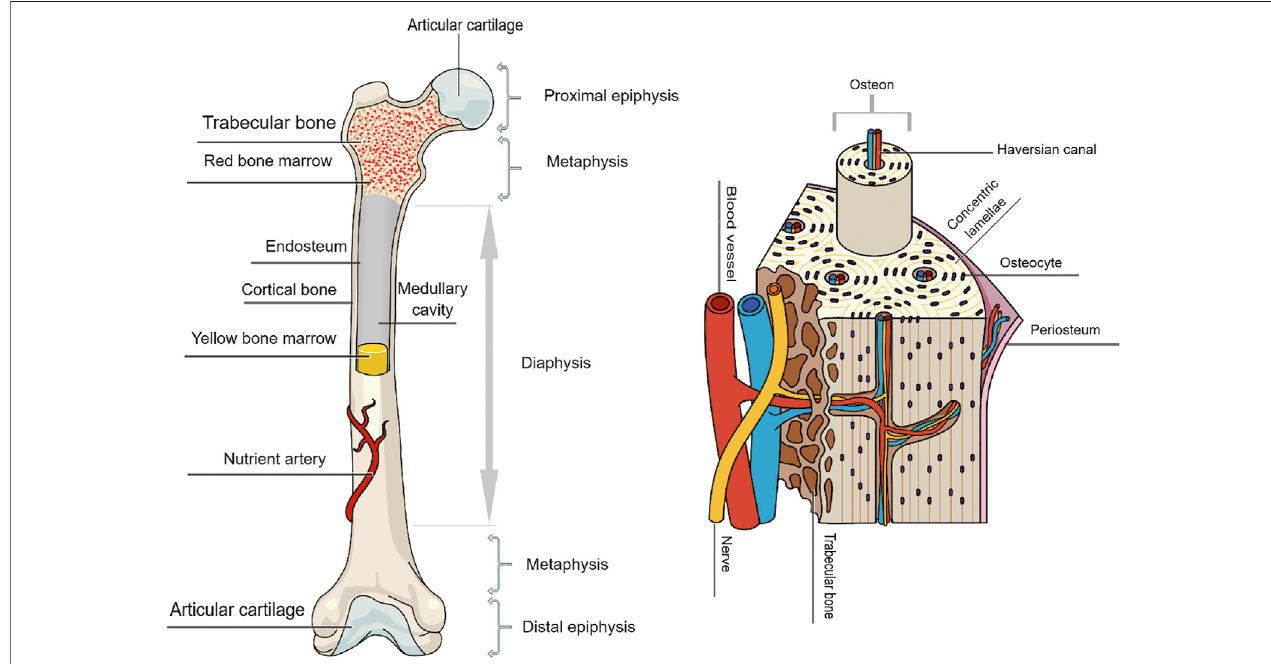
FIGURE 1 | An overall schematic representation of long bone